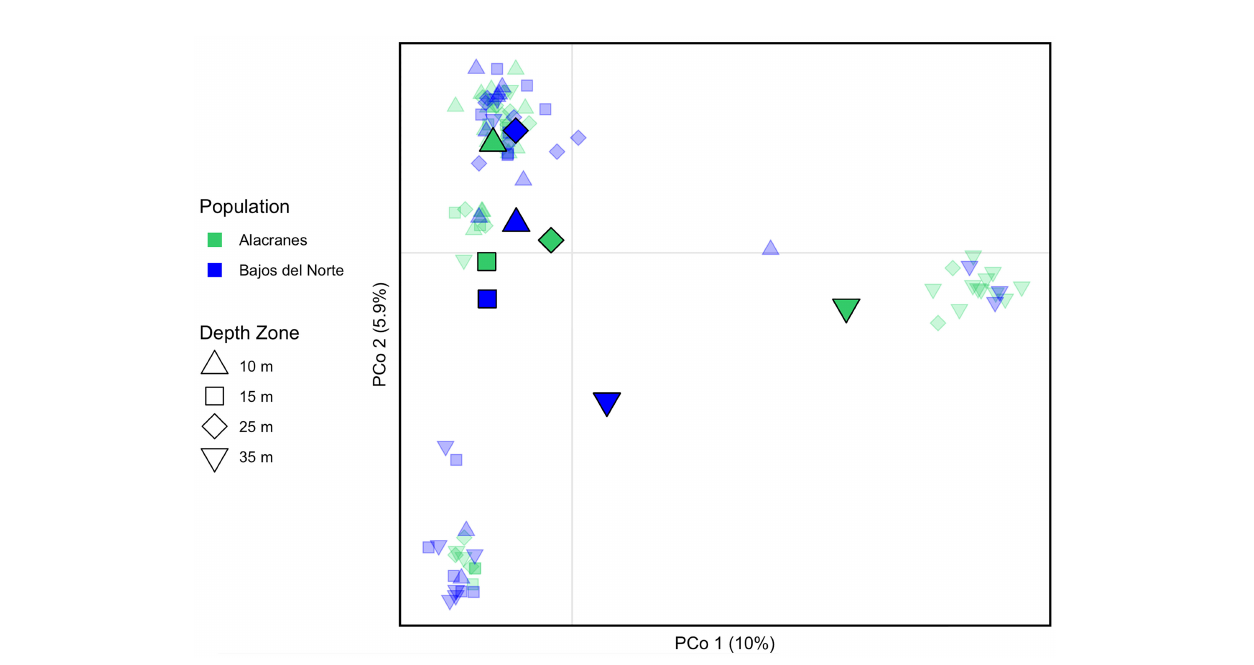
FIGURE 2 | Principal coordinates analysis based on identity-by-state (IBS) distance matrix. Individual samples are represented by small, transparent symbols whereas population centroids are indicated by larger, solid symbols. Color indicates reef and shape indicates depth zone of each sample and population centroid. The percent variation explained by each axis is